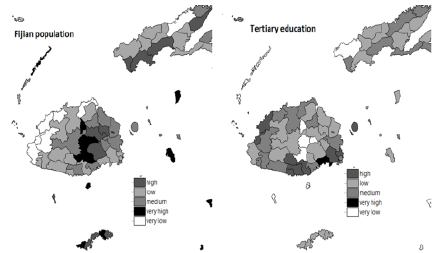
Figures 3a. Fiji islands map showing degrees of land availability per tikina . Range: Less than 5 to 40 km 2 of land ―available‖ per average village or settlement; and Figure 3b . The country‘s map showing degrees of forestry employment per tikina Range: 0 to 247 workers. Wood industries are Fiji‘s fifth most important export satisfying the domestic demands (Walsh and Crosbie 2006).